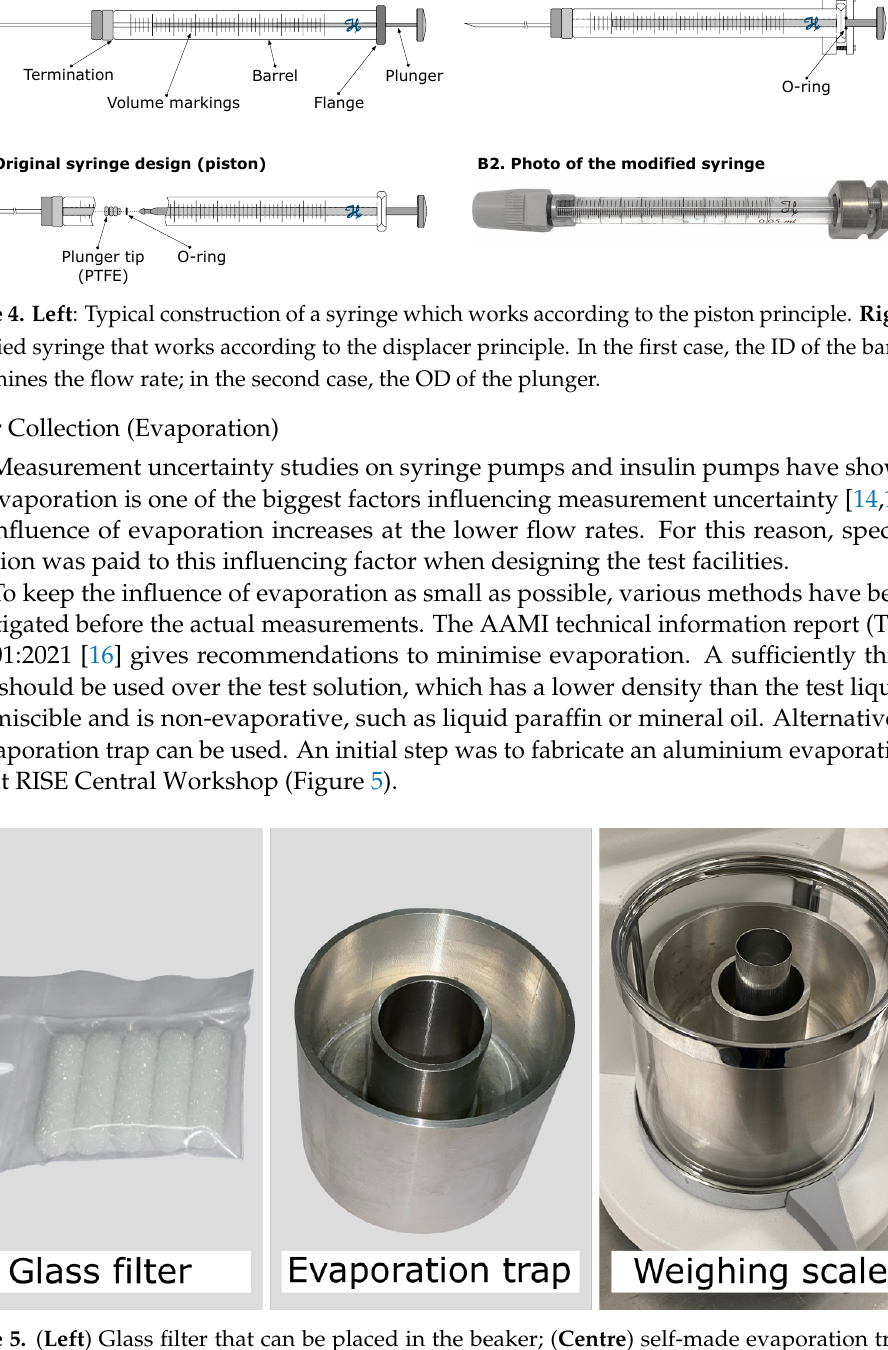
Figure 5. ( Left ) Glass filter that can be placed in the beaker; ( Centre ) self-made evaporation trap; ( Right ) evaporation trap and beaker on the